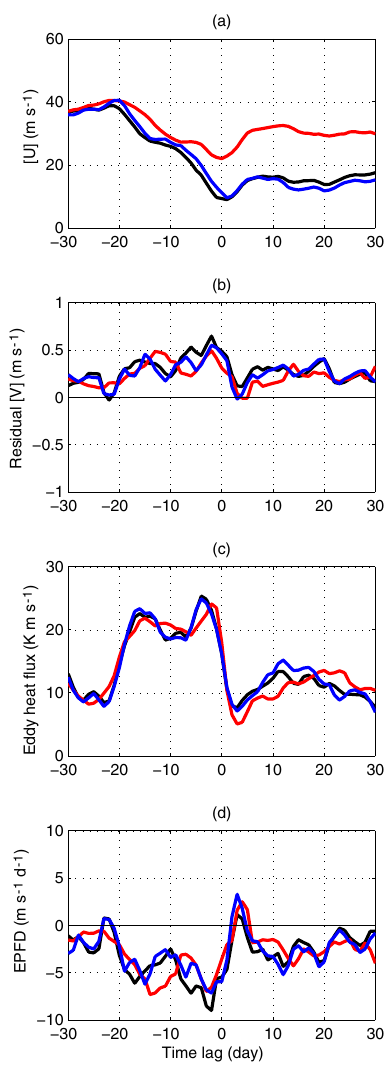
Figure 11. Composite time series with respect to the maximum of the 21-day mean heat flux of waves 1–3 in each DJF sea- son for STDD (black), CONV (blue), and AMIP (red): (a) zonal mean zonal wind at 60 ◦ N, 10hPa, (b) residual mean meridional wind in the transformed Eulerian-mean equations at 60 ◦ N, 10hPa, (c) heat flux of waves 1–3 at 40–90 ◦ N, 100hPa, and (d) EP flux divergence–convergence (EPFD) of waves 1–3 at 60 ◦ N, 10hPa. The lag = 0 day denotes when the 21-day mean heat flux maxi- mizes. The full period data are used for